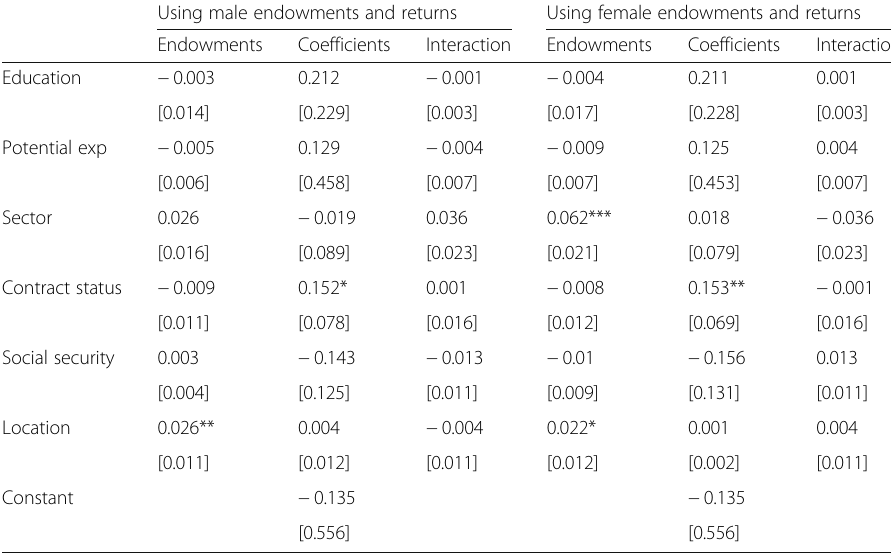
Table 16 Detailed three-fold income decompositions: Moldova Using male endowments and returns Using female endowments and